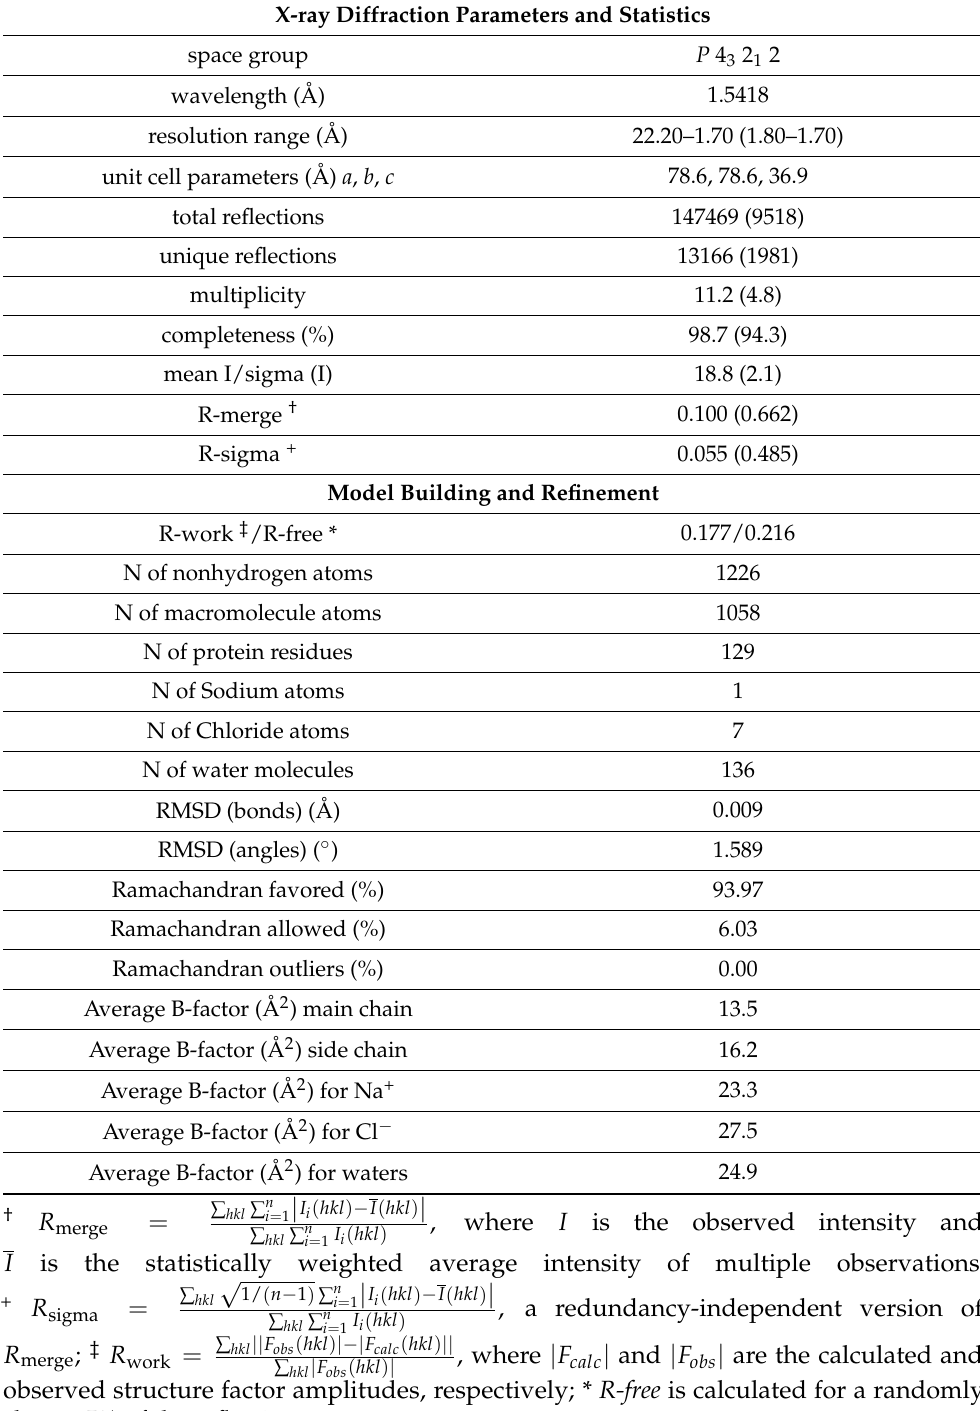
Table 2. Statistics of X-ray diffraction data collection and automated model building and refinement for HEWL crystals (values for the last resolution shell are in